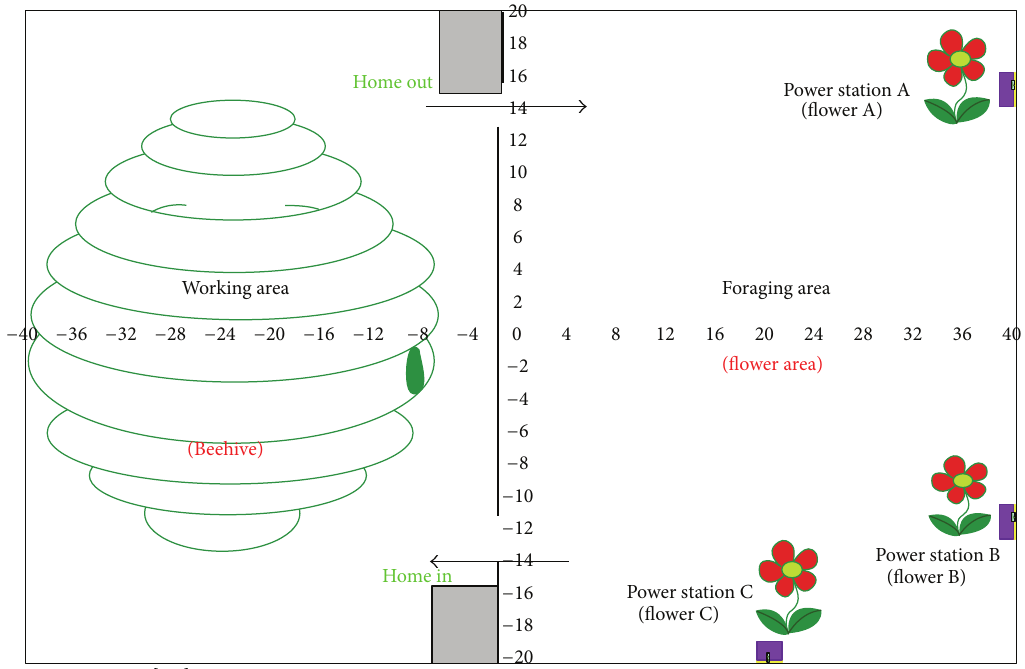
Figure 2: Environment for experiment of multimobile